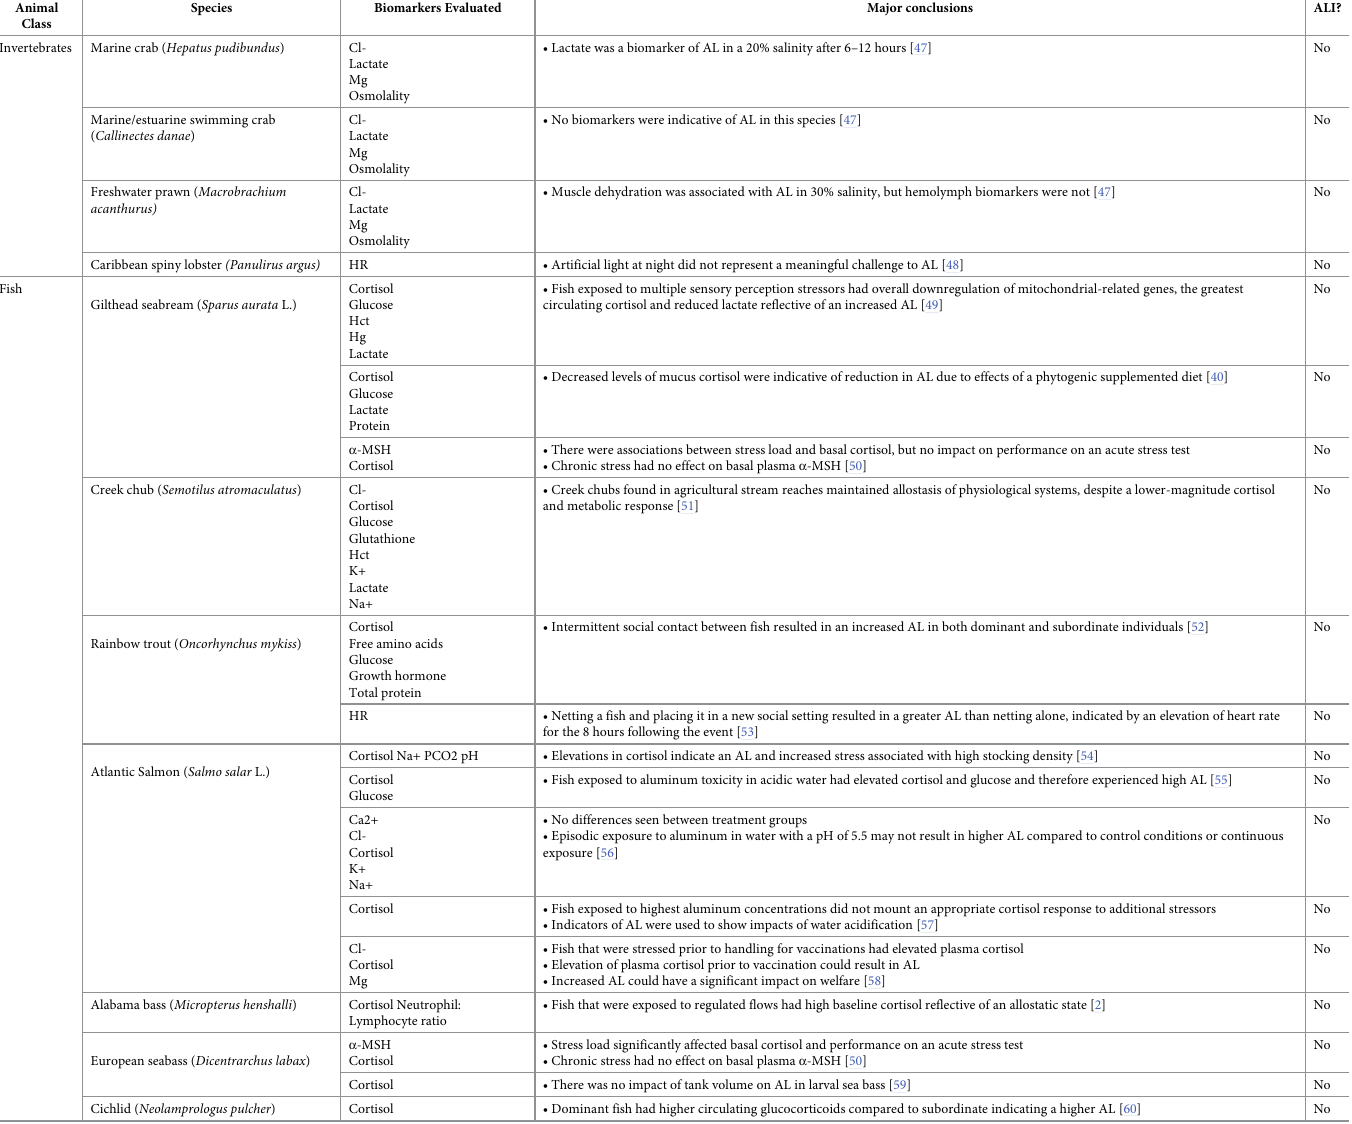
Table 1. Summary of publications that directly assessed allostatic load in